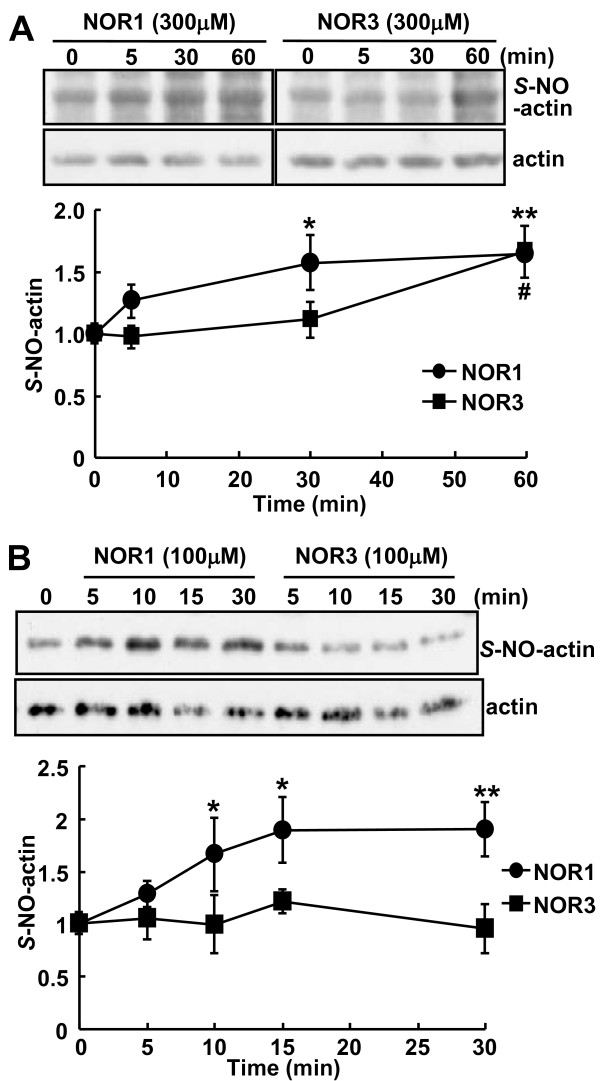
S-Nitrosylation of actin by NO donors. A. Time courses of S-nitrosylation of actin in PC12 cells by NO donors. PC12 cells (7 × 105 cells/dish) cultured in 6-cm dishes were exposed to 300 μM NOR1 or NOR3 for the indicated times. The cell lysates in HEN buffer were subjected to the biotin-switch assay as described in "Methods." Samples were resolved by non-reducing SDS-PAGE and immunoblotted with anti-biotin and anti-actin antibodies for S-nitrosylated and total actin, respectively. Intensity of bands was quantified by using ImageJ. The extent of S-nitrosylated actin was normalized to total actin, and the ratio (mean ± SEM, n = 6) of S-nitrosylated actin to total actin at 0 min was taken as "1." *P < 0.05; **P < 0.01 vs. 0 min for NOR1; # P < 0.05 vs. 0 min for NOR3. B. Time courses of S-nitrosylation of actin by NO donors. Purified actin (5 μg) was incubated with 100 μM NO donor NOR1 or NOR3 for the indicated times and subjected to the biotin-switch assay. *P < 0.05; **P < 0.01 vs. 0 min for NOR1.